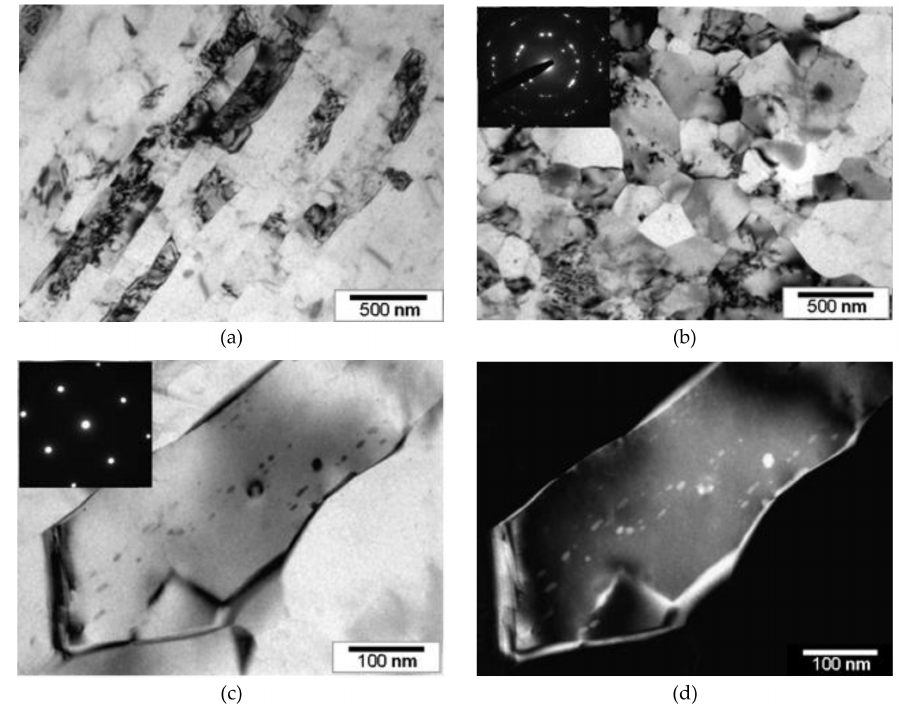
Figure 3. The Al 6101 alloy after ECAP-C processing, artificial aging and CD: ( a , c , d ) microstructure on longitudinal section; ( b ) transversal section and corresponding SAED patterns; ( c ) bright field TEM image and corresponding SAED patterns (the crystal is close to the [001] zone axis orientation); and ( d ) dark field TEM image showing spherical second-phase nanoprecipitates present in the Al matrix,